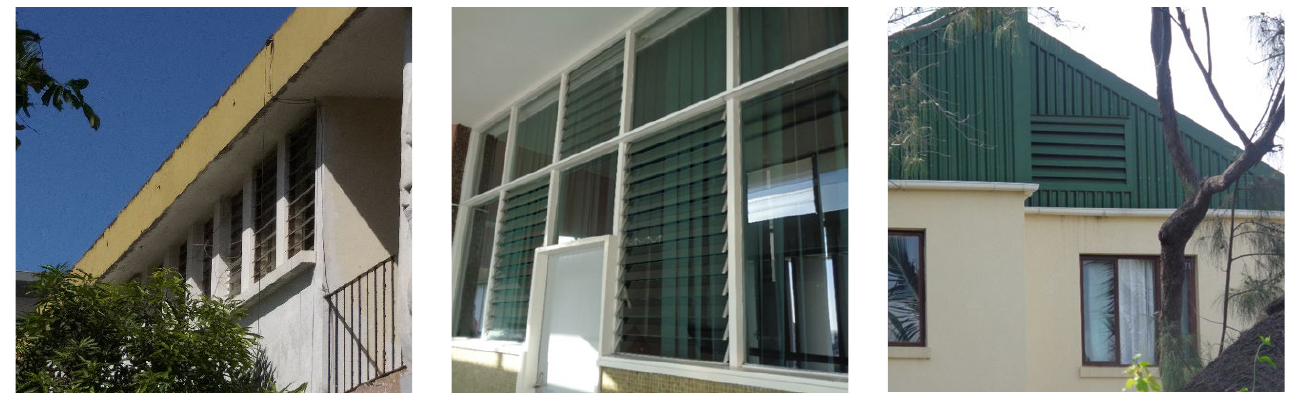
Figure 8. Example of ventilation using adjustable vents in windows to promote evaporative cooling. In addition, ventilation through the chimney effect with an air inlet at the bottom and outlet at